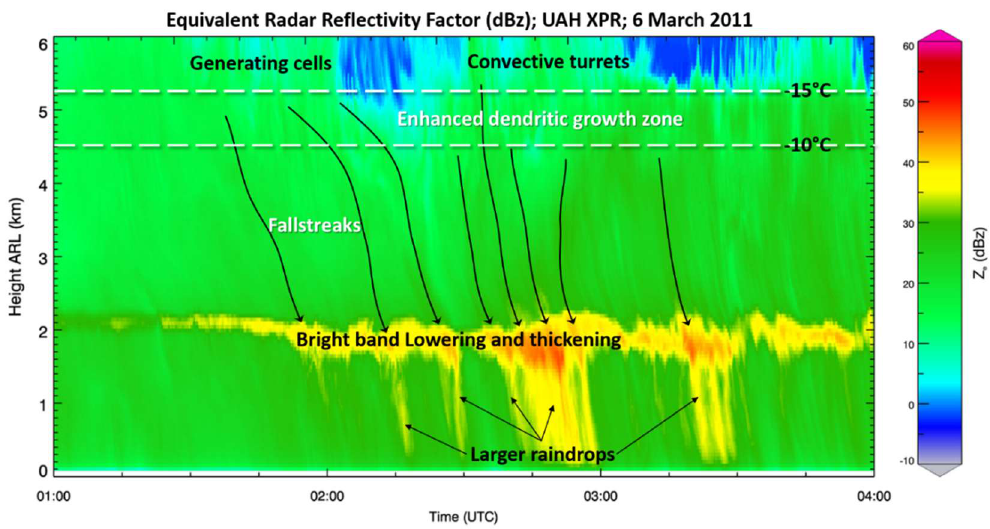
Figure 1. A time-series of equivalent radar reflectivity above radar level (ARL) from the University of Alabama in Huntsville (UAH) X-band vertically pointing radar (XPR) measurements of a stratiform precipitation event in Huntsville, Alabama. Time is given in Universal Coordinated Time (UTC).